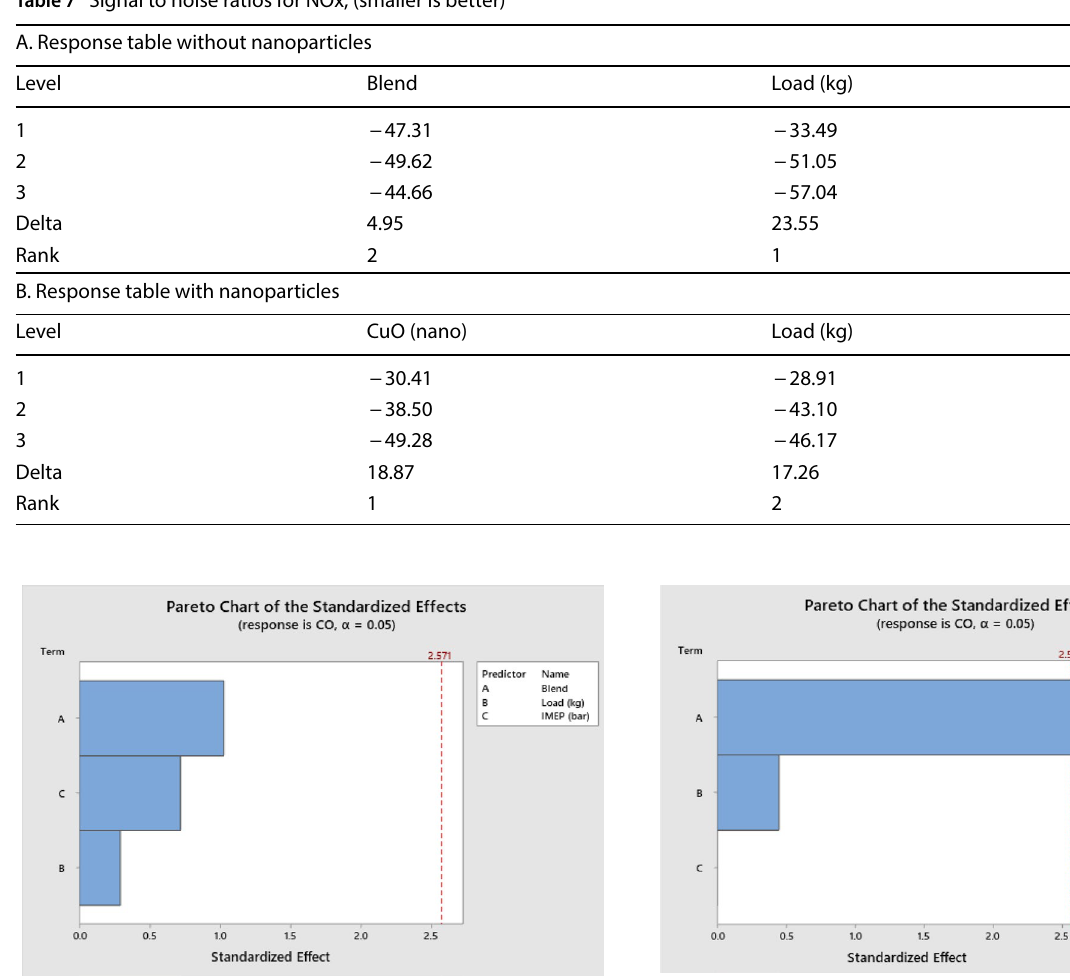
Fig. 12 Regression analysis: CO versus blend, load (kg), IMEP (bar) without nanoparticle